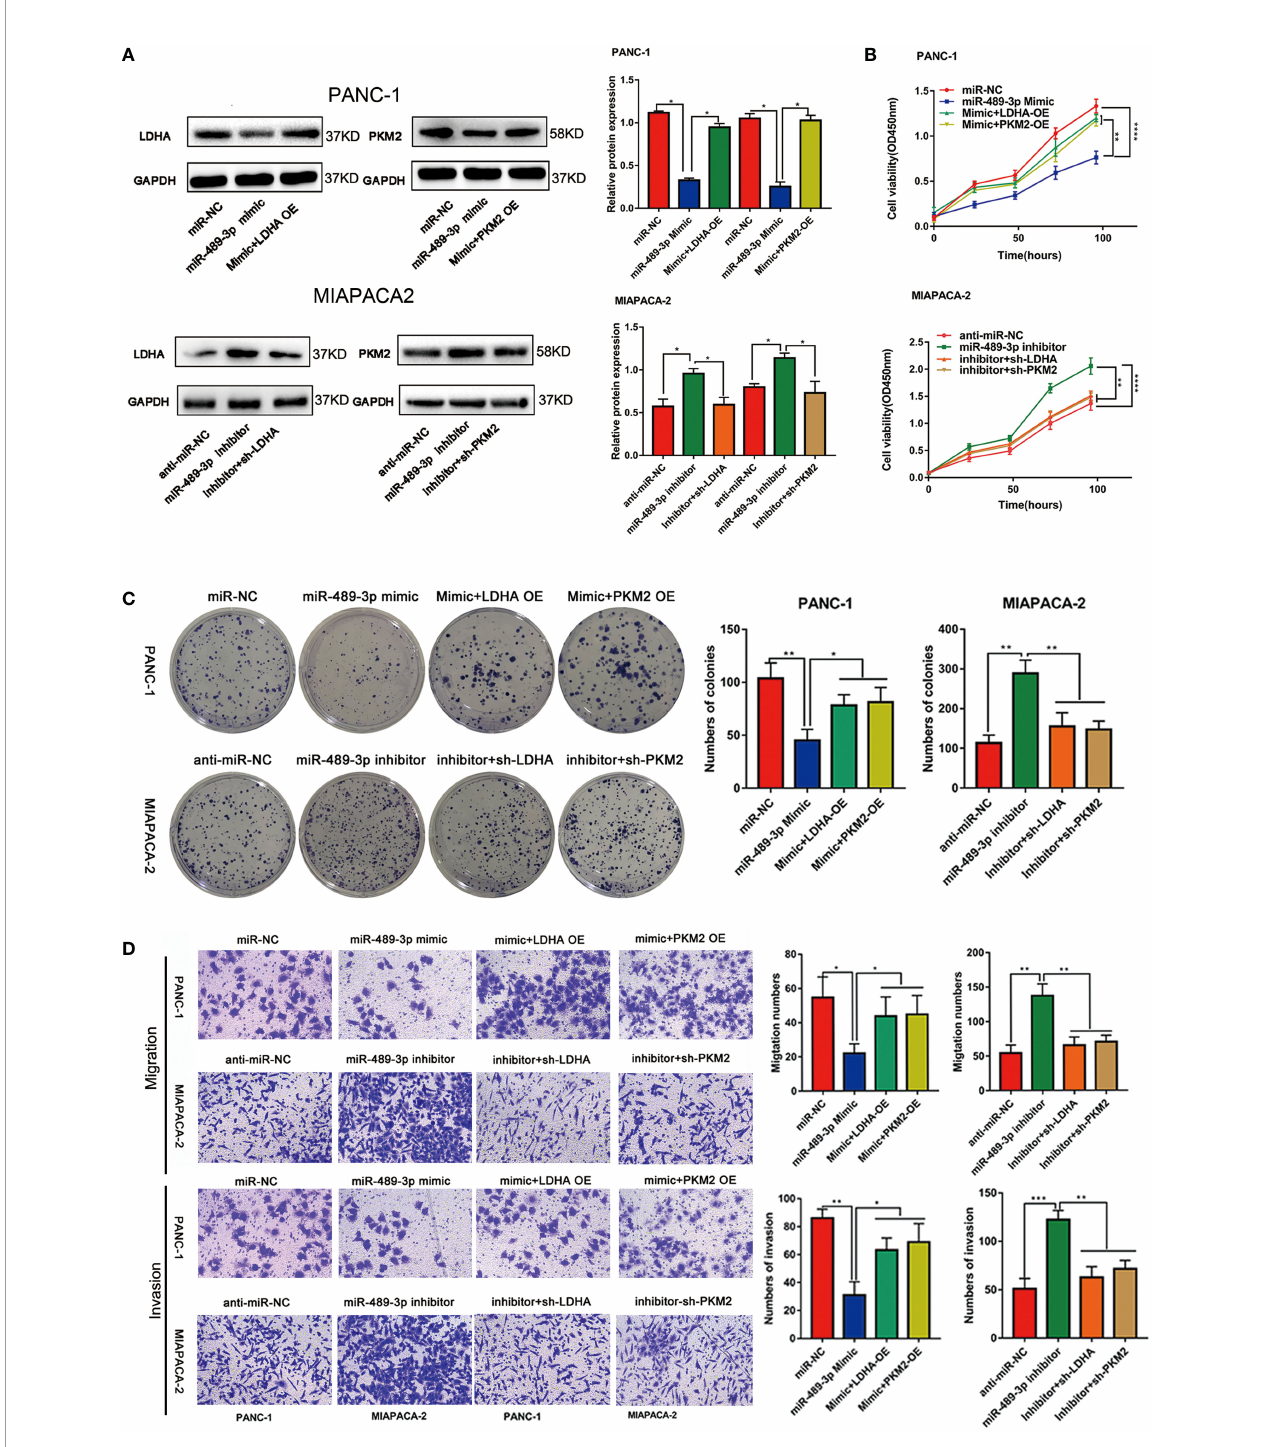
FIGURE 5 | LDHA and PKM2 restored the function of miRNA-mediated proliferation and metastasis ability. (A) Western blot experiments showed that the relative expression of LDHA and PKM2 in PC cells transfected with miR-489-3p mimic, inhibitor, LDHA, PKM2 overexpressed plasmid or shRNA. (B, C) CCK8 and plate cloning and transwell migration assays showed that the proliferation ability of PC cells transfected with miR-489-3p mimic, inhibitor, LDHA, PKM2 overexpressed plasmid or shRNA. (D) Transwell assays show that the migration and invasion ability of PC cells transfected with miR-489-3p mimic, inhibitor, LDHA, PKM2 overexpressed plasmid or shRNA. (*P < 0.05, **P < 0.01, ***P < 0.001, ****P <